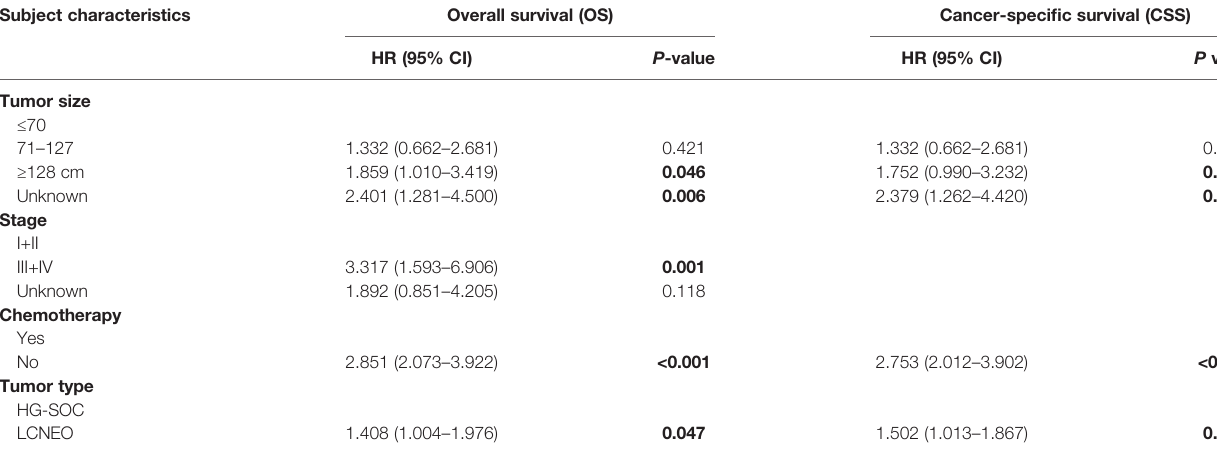
TABLE 4 | Multivariable analysis of survival outcomes after propensity-score